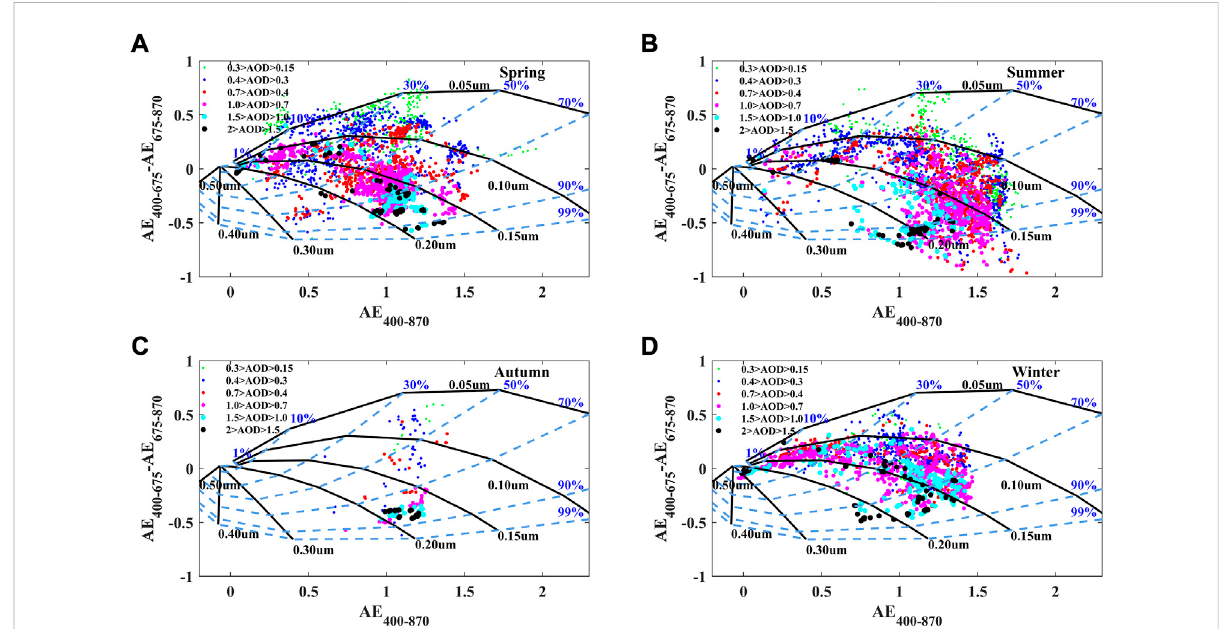
FIGURE 6 Seasonal (Spring (A) , Summer (B) , Autumn (C) , Winter (D) ) means Ångström exponent differences, δ AE = AE 400-675 -AE 675-870 as a function of AE 400-870 and AOD 675 . Different colored dots indicate different AOD ranges.